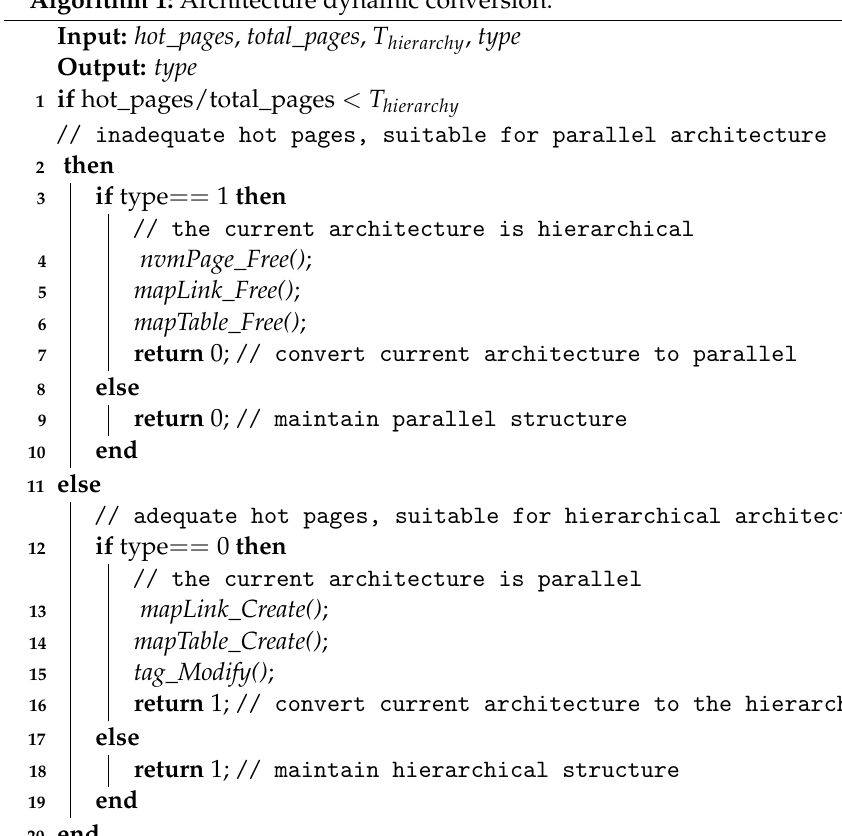
Algorithm 1: Architecture dynamic